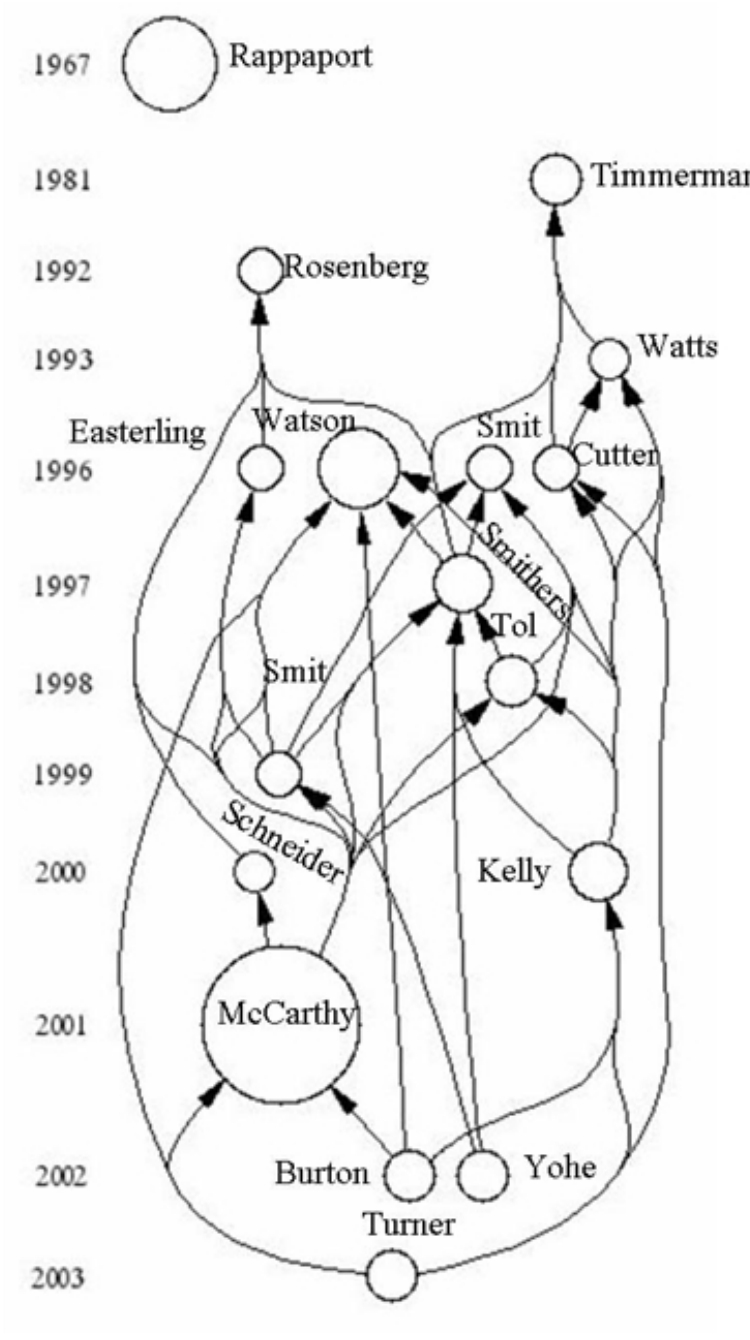
Fig. 6. Paper citation network of the most highly cited papers within the adaptation knowledge domain (Threshold 20 citations within the data set). The node size denotes the number of citations, the arrows refer to